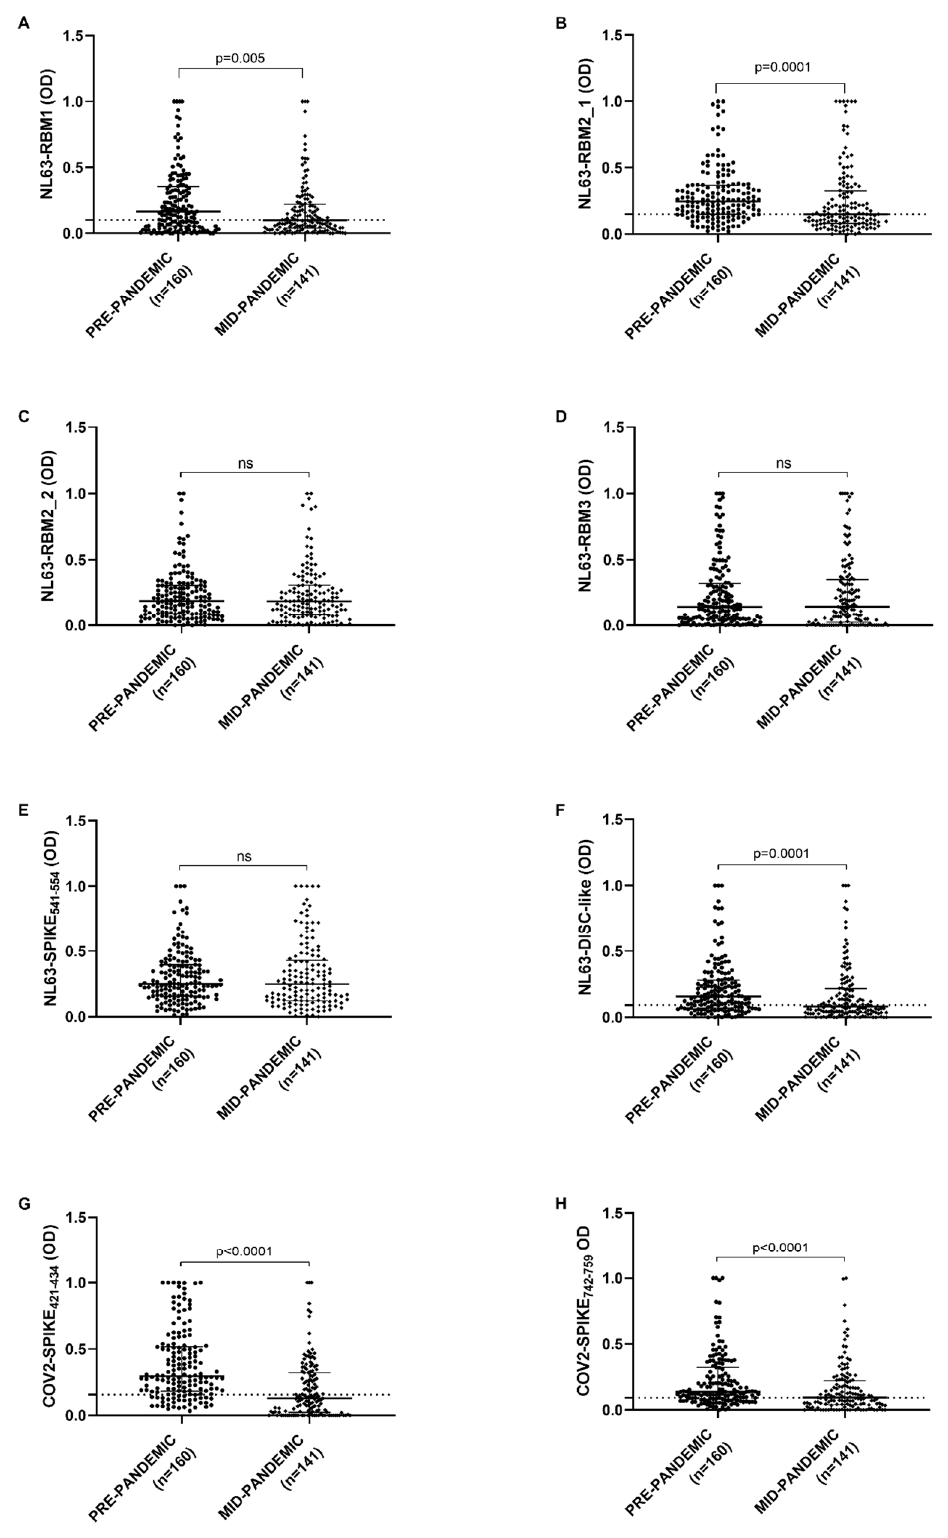
Figure 1. ELISA-based analysis of Abs reactivity against SARS-CoV-2 and HCoV-NL63 derived peptides. Plasma samples were tested against NL63-RBM1 ( A ), NL63-RBM2_1 ( B ), NL63-RBM2_2 ( C ), NL63-RBM3 ( D ), NL63-SPIKE 541–554 ( E ), NL63-DISC-like ( F ), COV2-SPIKE 421–434 ( G ), and COV2-SPIKE 742–759 ( H ) peptides. Scatter plots represent median with interquartile range. Dashed lines represent thresholds used to assess the samples positivity.